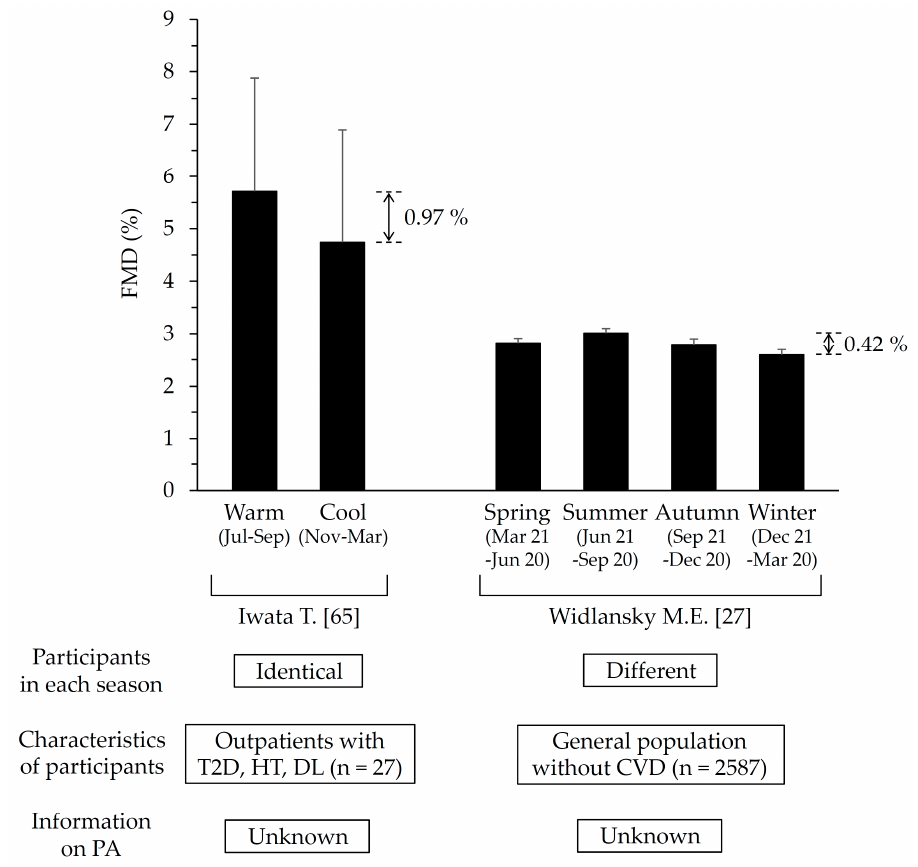
Figure 1. Comparisons of annual ranges (based on the subtraction of the minimum value from the maximum value during the year) of flow-mediated vasodilation (FMD) in studies that investigated seasonal variations in FMD. Values are presented as mean ± standard deviation. T2D: type 2 diabetes; HT: hypertension; DL: dyslipidemia; CVD: cardiovascular disease; PA: physical activity.